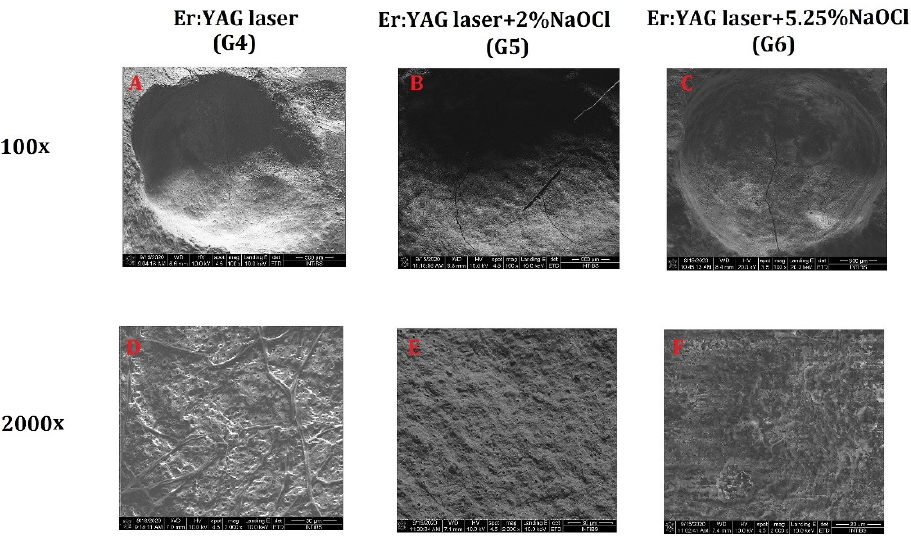
Figure 3. Dentin surface after the removal of the composite filling using the Er:YAG laser ( A , D ) and after additional dentin conditioning with 2% NaOCl ( B , E ) and 5.25% NaOCl ( C , F ).